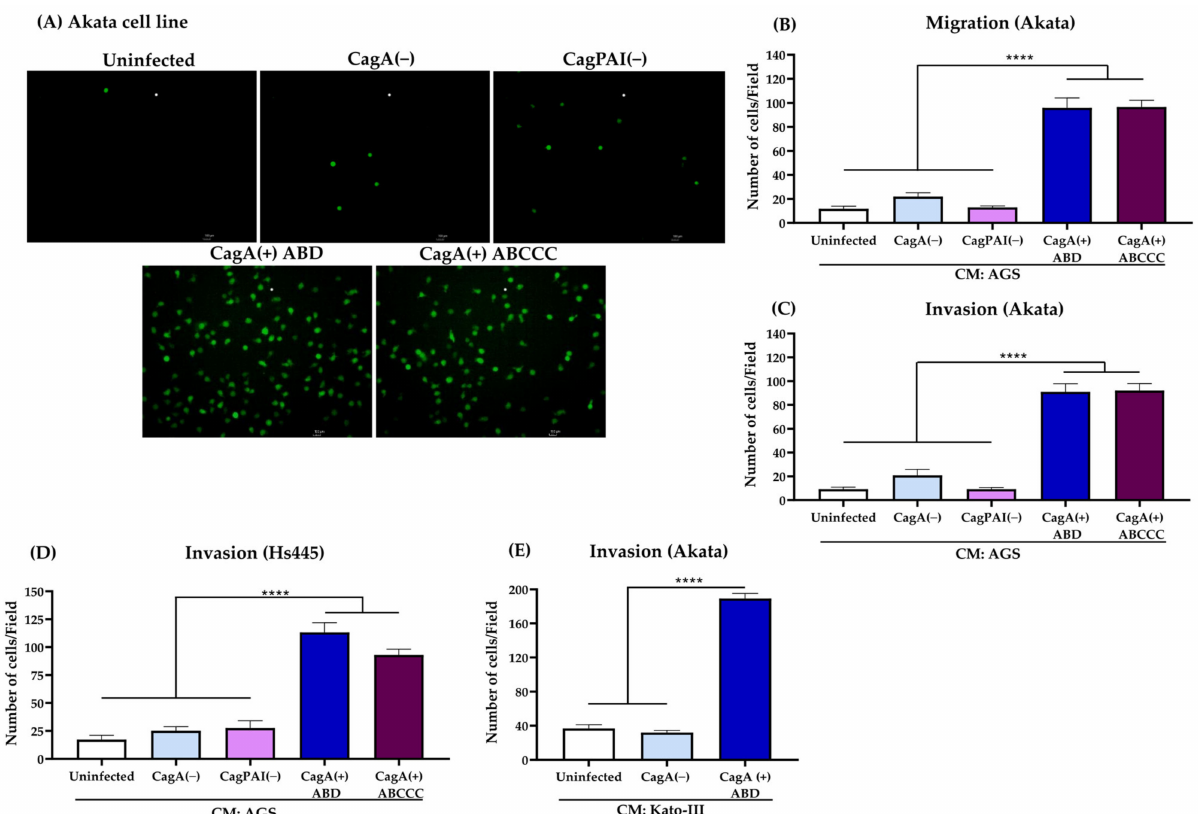
Figure 1. EBV-infected B lymphocytes are chemoattracted by components of conditioned media (CM) obtained from gastric epithelial cells infected with H. pylori strains. ( A ) Representative fluorescence images of Akata cells (EBV-GFP positive cells) chemoattracted to CM of AGS cells uninfected or infected with H. pylori CagA( − ) or CagA(+) strains. The scale bars indicate 100 µ m, magnification 10 × . ( B , C ) Plots of the mean numbers of chemoattracted Akata cells in migration ( B ) and invasion assays ( C ). ( D , E ) Plots of invading Hs445 cells chemoattracted to CM from AGS cells infected with H. pylori strains, or invading Akata cells chemoattracted to CM from Kato-III infected with H. pylori strains. Graphs represent the mean ± SEM of the number of migrating or invading cells counted from five random microscope fields of three independent experiments. Non-parametric Kruskal–Wallis and Dunn’s post-hoc tests were used for the statistical analysis; **** p <